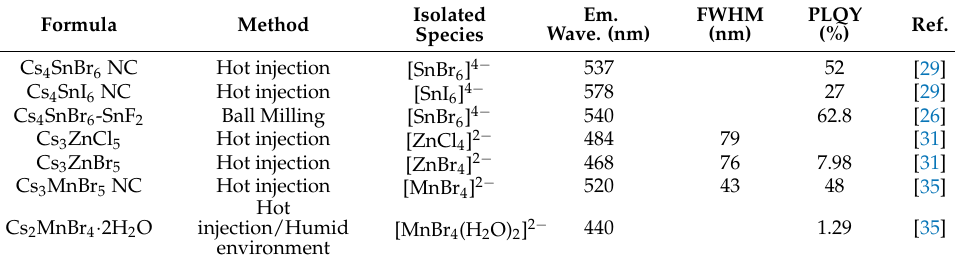
Figure 4. ( a ) Sunlight and UV light image of different amount of Sb 3+ in Cs 3 ZnCl 5 . ( b ) Photolumi- nescence excitation and ( c ) emission spectra for Cs 3 ZnCl 5 :Sb 3+ at 620 nm and 320 nm, respectively. Reproduced with permission from [32], Copyright 2022, The Royal Society of Chemistry. Table 2. Properties of 0D metal halide with divalent